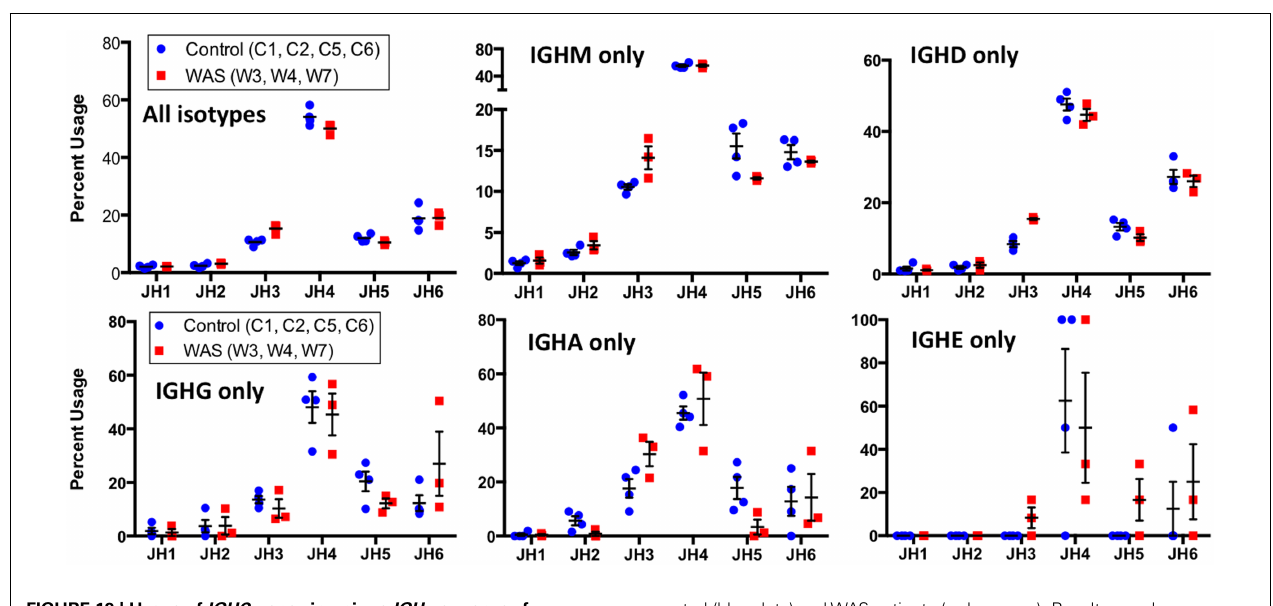
FIGURE 13 | Usage of IGHC genes in unique IGH sequences from WAS patients and controls . Usage of IGHC families is displayed as the percentage of the total number of unique clonotypes for both